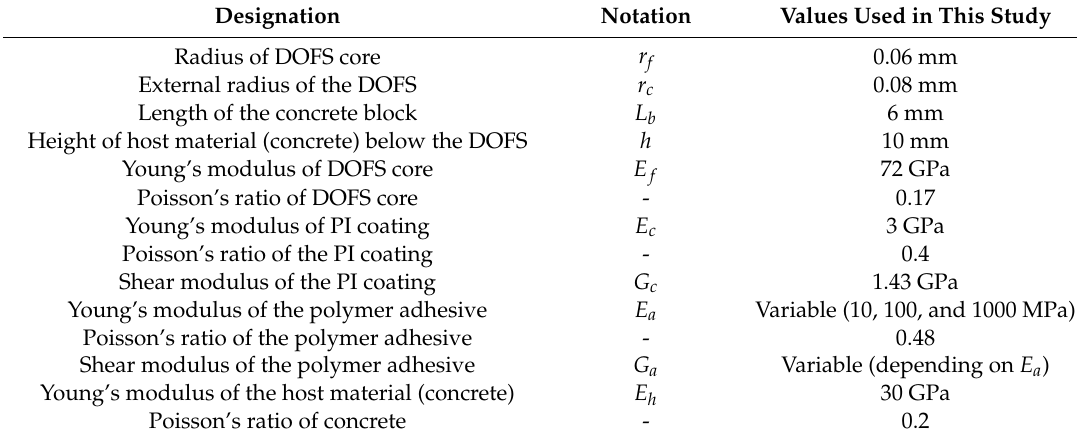
Table 1. Geometrical and mechanical characteristics used in theoretical analysis.